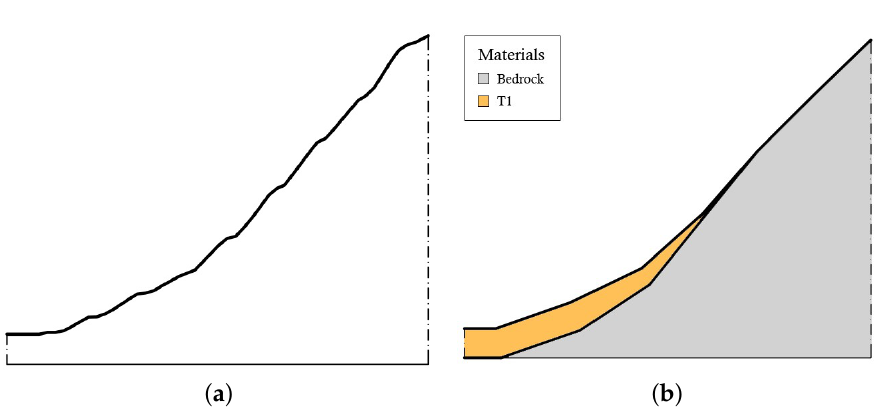
Figure 5. The calculation profile considered in the stability analysis for S1.